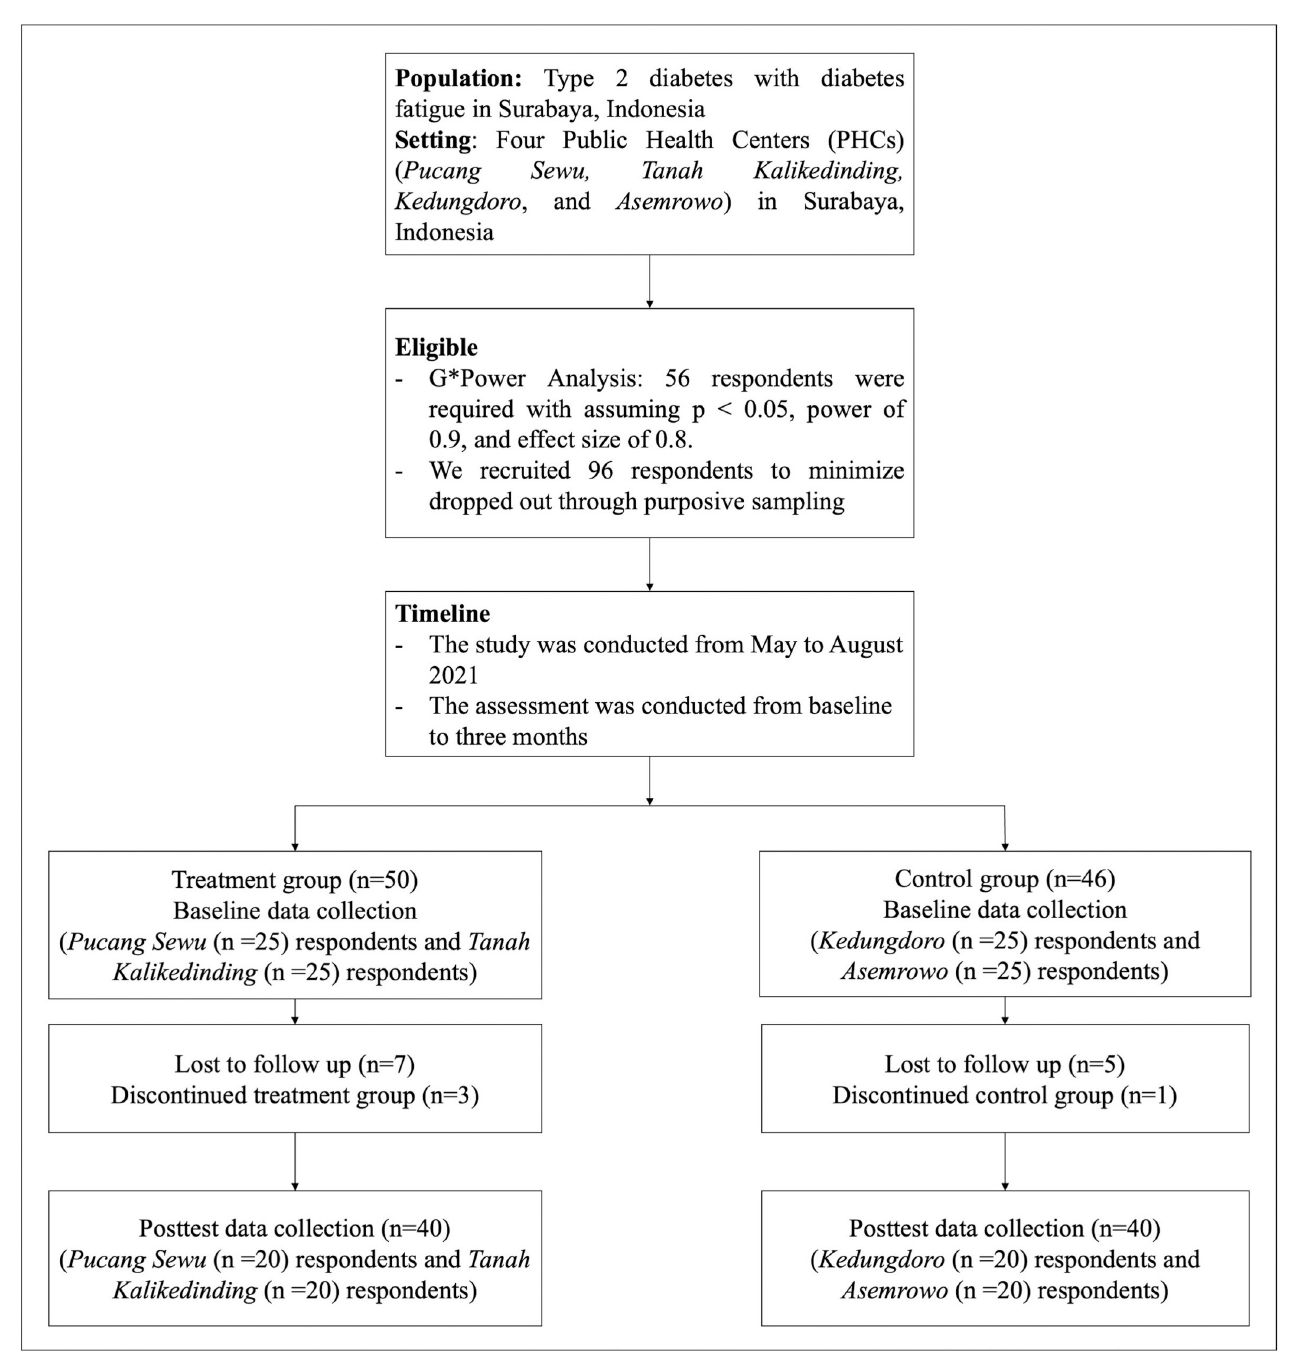
Fig 1. Sample diagram flow